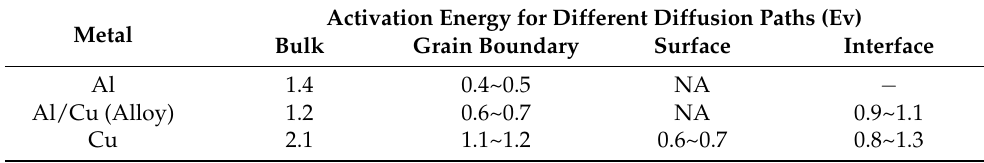
Table 2. Activation energy for different diffusion paths for Al, Al/Cu, and Cu metal